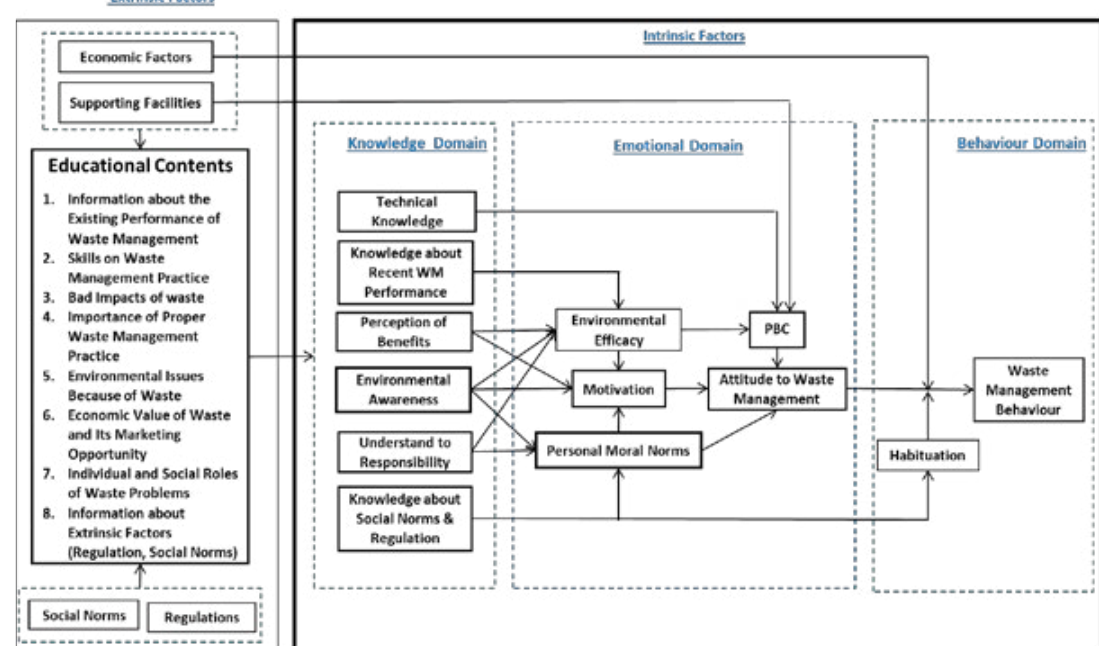
Fig. 3: The proposed model